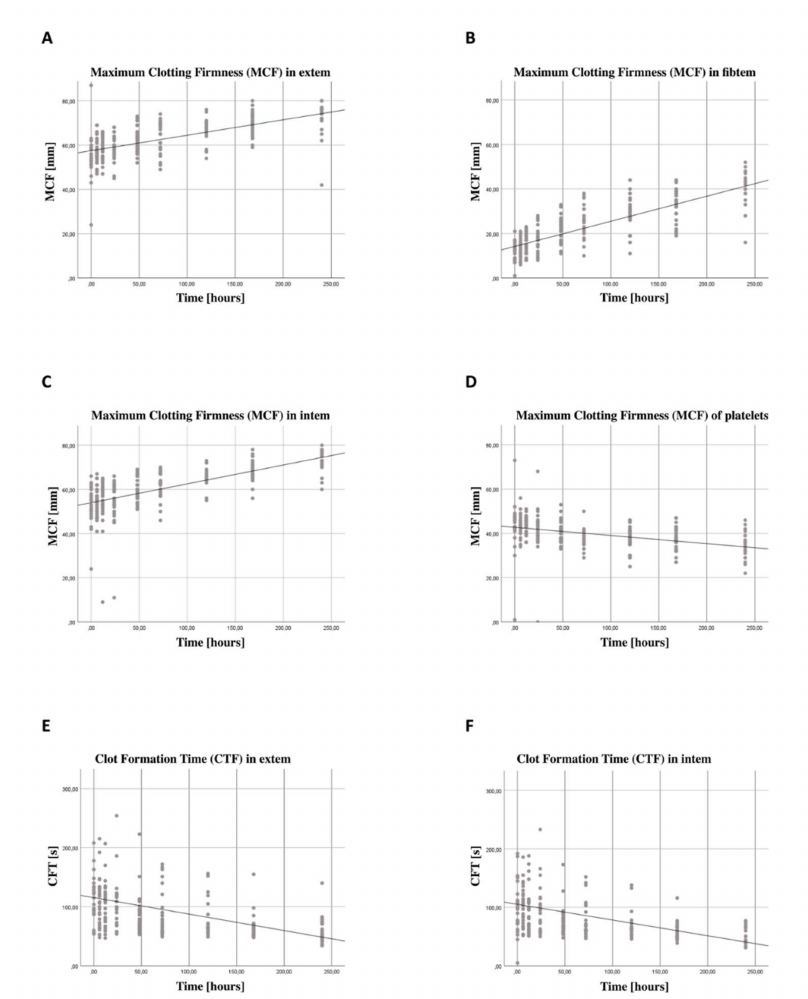
Figure 3. Thromboelastometric findings revealed a significant increase in MCF in extem, intem and fibtem, while platelet MCF decreased; CFT decreased in extem and intem . ( A ) The thromboe- lastometric data were collected using a ROTEM ® delta device. Blood was drawn on arrival in the emergency room (0), after 6, 12, 24 and 72 h, as well as after 5, 7 and 10 days. The maximum clot firmness (MCF) on the extem panel, representing the coagulation function in the extrinsic coagulation pathway, increased significantly over the first 10 days after trauma (B = 2.079, SE = 0.3016, 95% CI [1.488, 2.670], p < 0.001). ( B ) The same applies to the intem panel, representing the coagulation function in the intrinsic coagulation pathway, (B = 2.458, SE = 0.1717, 95% CI [2.121, 2.794], p < 0.001), and ( C ) the fibtem panel, representing the extrinsic coagulation pathway without the contribution of platelets, as these are inhibited by cytochalasin D, (B = 3.441, SE = 0.1761, 95% CI [0.072, 0.093], p < 0.001). ( D ) The platelet MCF, however, represented by the subtraction between extem MCF and fibtem MCF, decreased over time (B = − 1.153, SE = 0.2243, 95% CI [-1.593; -0.714]), p < 0.001), which is indicative of a platelet dysfunction. As the clot gets firmer over time, it also forms faster. ( E ) The clot formation time (CFT) decreases in both extrinsic (B = − 9.858, SE = 3.0001, 95% CI [ − 15.738; − 3.987], p = 0.001), and ( F ) intrinsic coagulation pathways (B = − 9.361, SE = 3.2470, 95% CI [ − 15.725; − 2.997], p < 0.01). The regression line shown here is for illustrative